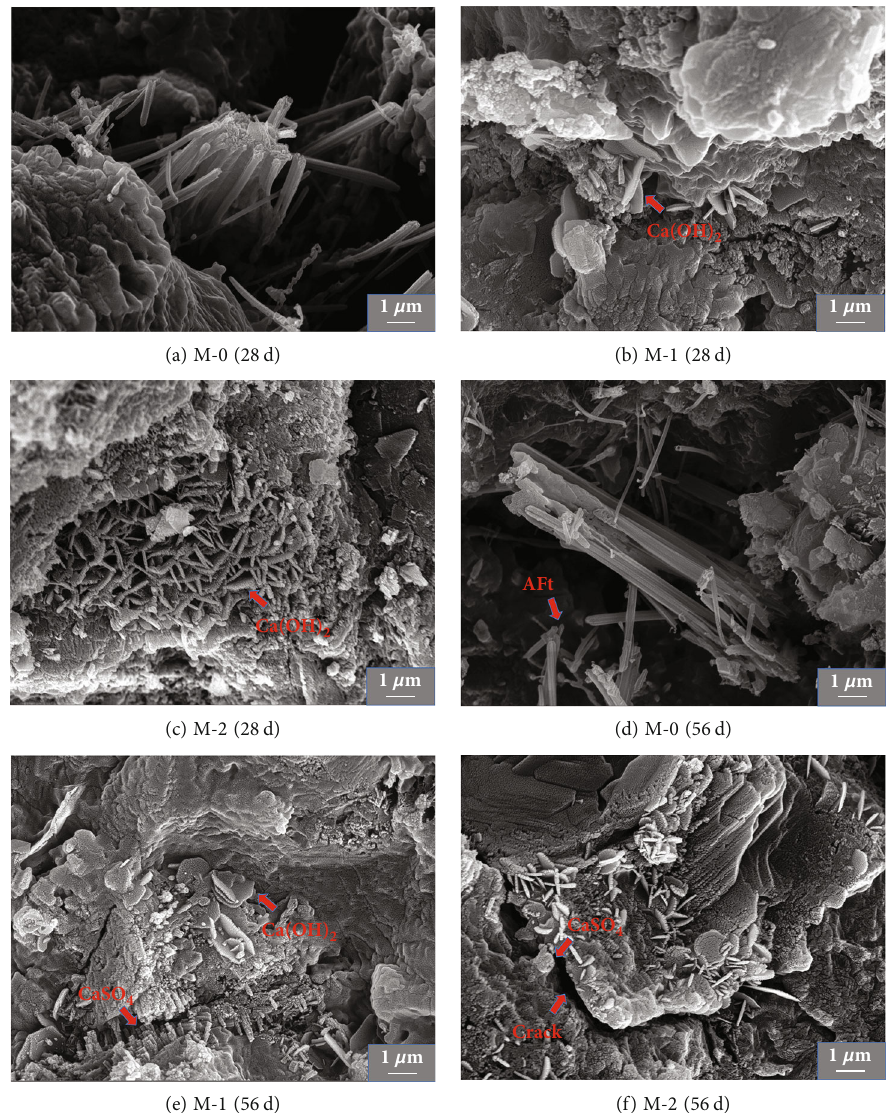
Figure 6: Microstructure of steel slag concrete modi fi ed by sulfate solution